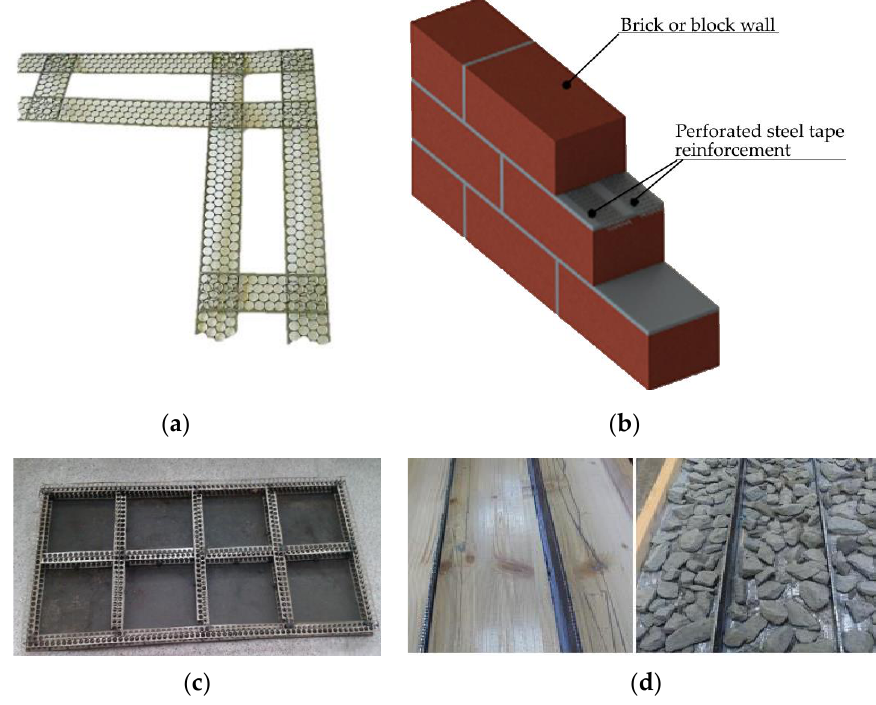
Figure 9. PMMs use different structural technologies: ( a , b ) PMM in masonry, ( c ) stiffeners in the mould members, ( d ) members providing timber-to-concrete connections in timber–concrete floor